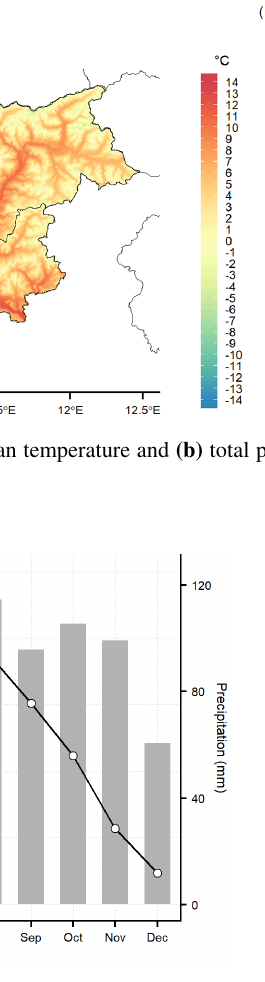
Figure 9. Mean regional annual cycle of monthly mean temperature and total precipitation based on the 1981–2010